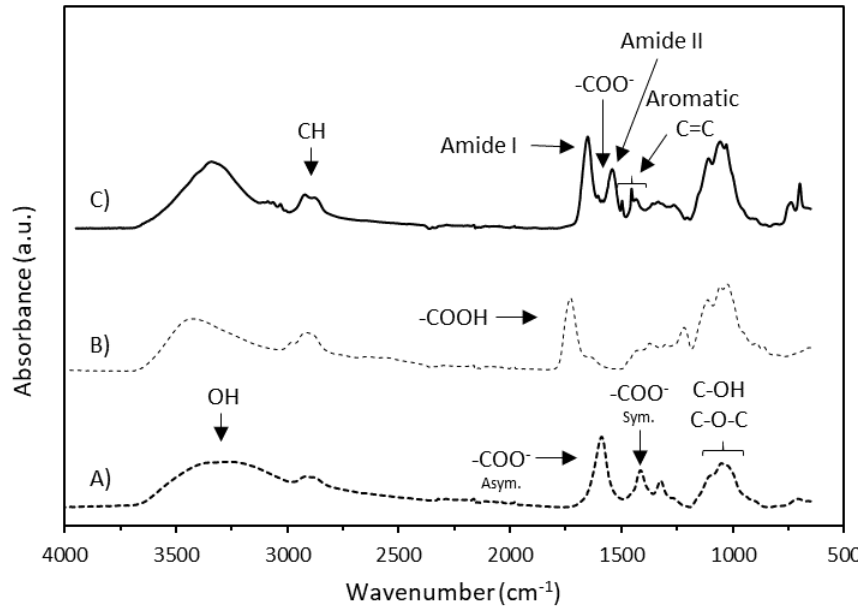
Figure 3. FT-IR of NaCMC (A,-- -----), HCMC (B, ········· ) and CMC 1.2 -Benz (Table 1, Entry 3) (C,—). Figure 3. FT-IR of NaCMC (A, ), HCMC (B, ) and CMC 1.2 -Benz (Table 1, Entry 3) (C, ).